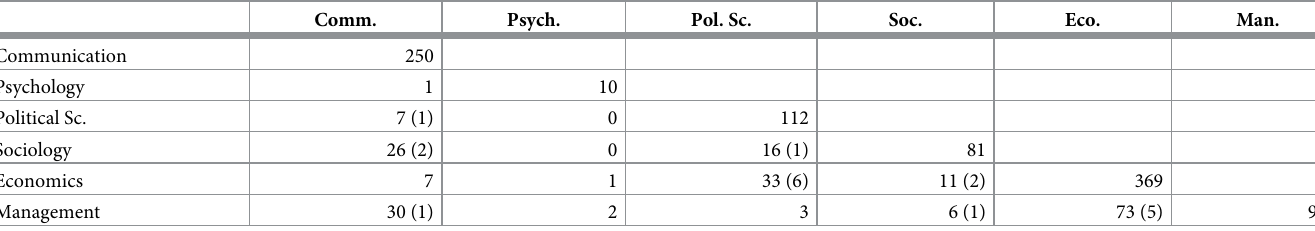
Table 3. Editorial board interlockings within and between fields. Comm.